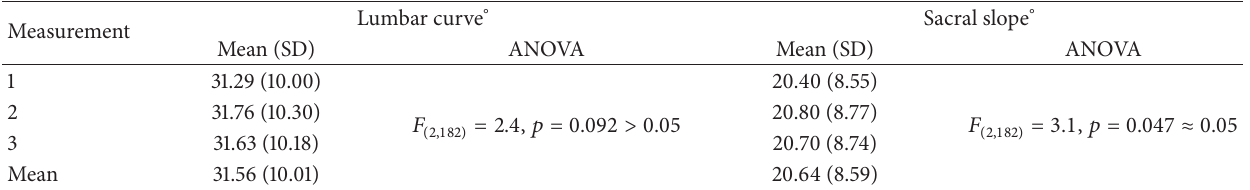
Table 1: Lumbar curve and sacral slope mean (SD) values for the 3 measurements, the mean of 3 measurements, and repeated measures ANOVA